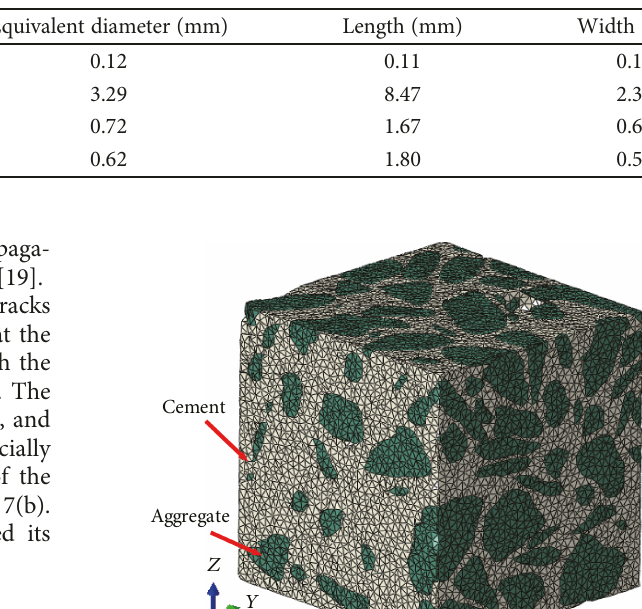
Table 4: Statistical analysis for voids in the concrete cube.